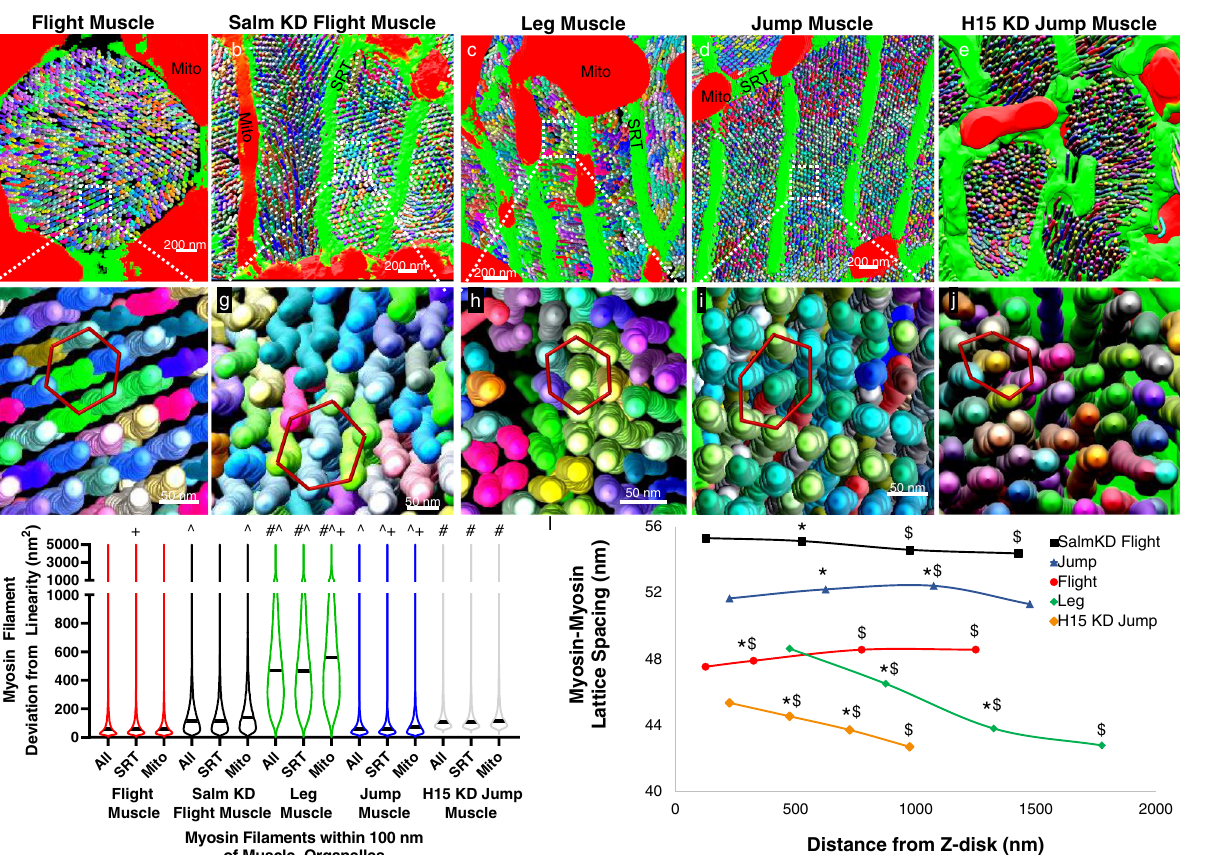
Fig. 5 | Muscle speci fi cation factors salm and H15 regulate myosin fi lament curvature and myosin-myosin lattice spacing in Drosophila muscle. a – e 3D renderings of myosin fi laments (various colors) and their proximal mitochondria (mito, red) and sarcoplasmic reticulum/t-tubules (SRT, green) in Drosophila fl ight ( a ), salm KD fl ight ( b ), leg ( c ), jump ( d ), and H15 KD jump ( e ) muscles. f – j 3D rendering of myosin fi lament lattice in Drosophila fl ight ( f ), salm KD fl ight ( g ), leg ( h ), jump ( i ), and H15 KD jump ( j ) muscles. k Myosin fi lament curvature for fi la- ments within 100nm of sarcomere boundary, SRT, and mitochondria. Thick black linesrepresentmedianvalues,thindottedlinesrepresentupperandlowerquartile values. Width of the violin plot represents the relative number of fi laments at a given value. # Signi fi cantly different from Jump muscles. ^ Signi fi cantly different